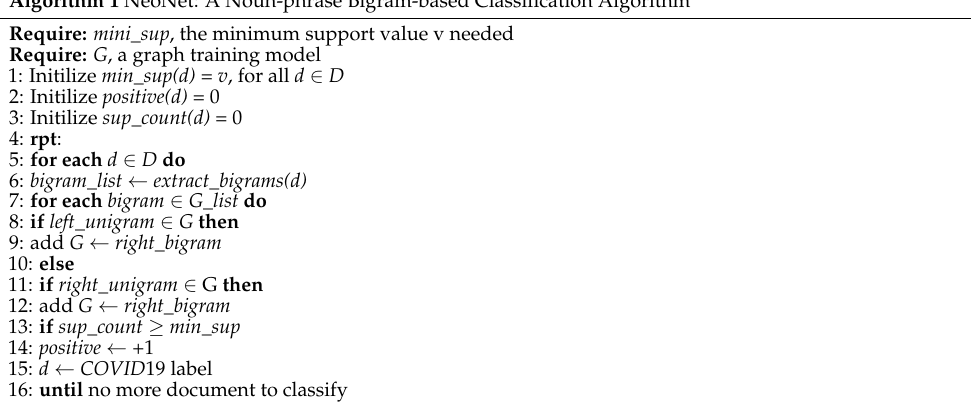
Algorithm 1 NeoNet: A Noun-phrase Bigram-based Classification